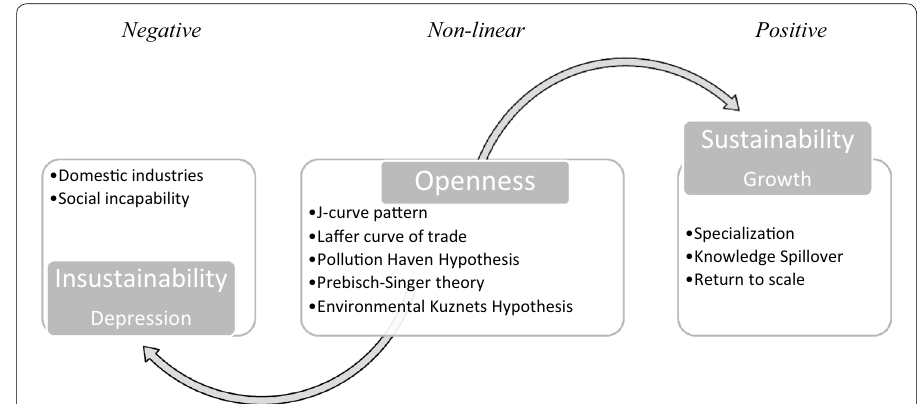
Fig. 1 Potential nexuses of openness and